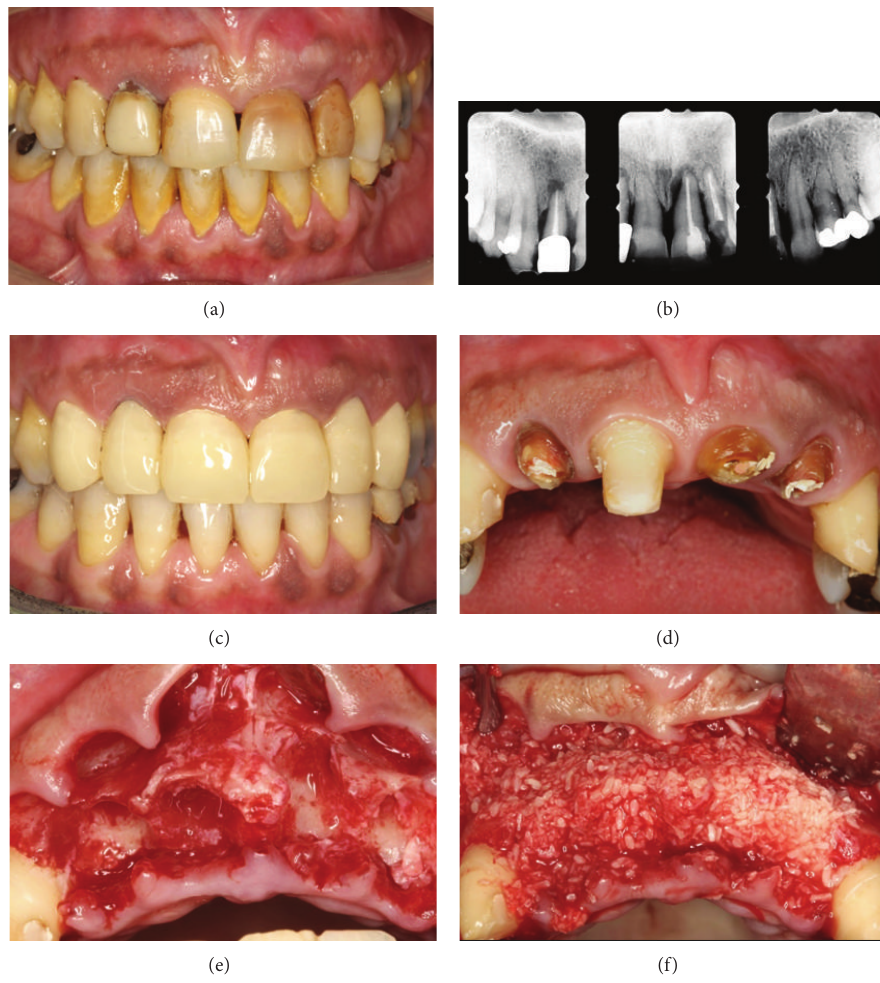
Figure 3: Case 3. Pretreatment: (a) clinical and (b) radiographic views. (c, d) Clinical views after periodontal treatment and construction of temporary prosthesis. After (e) extractions and (f) bone graft